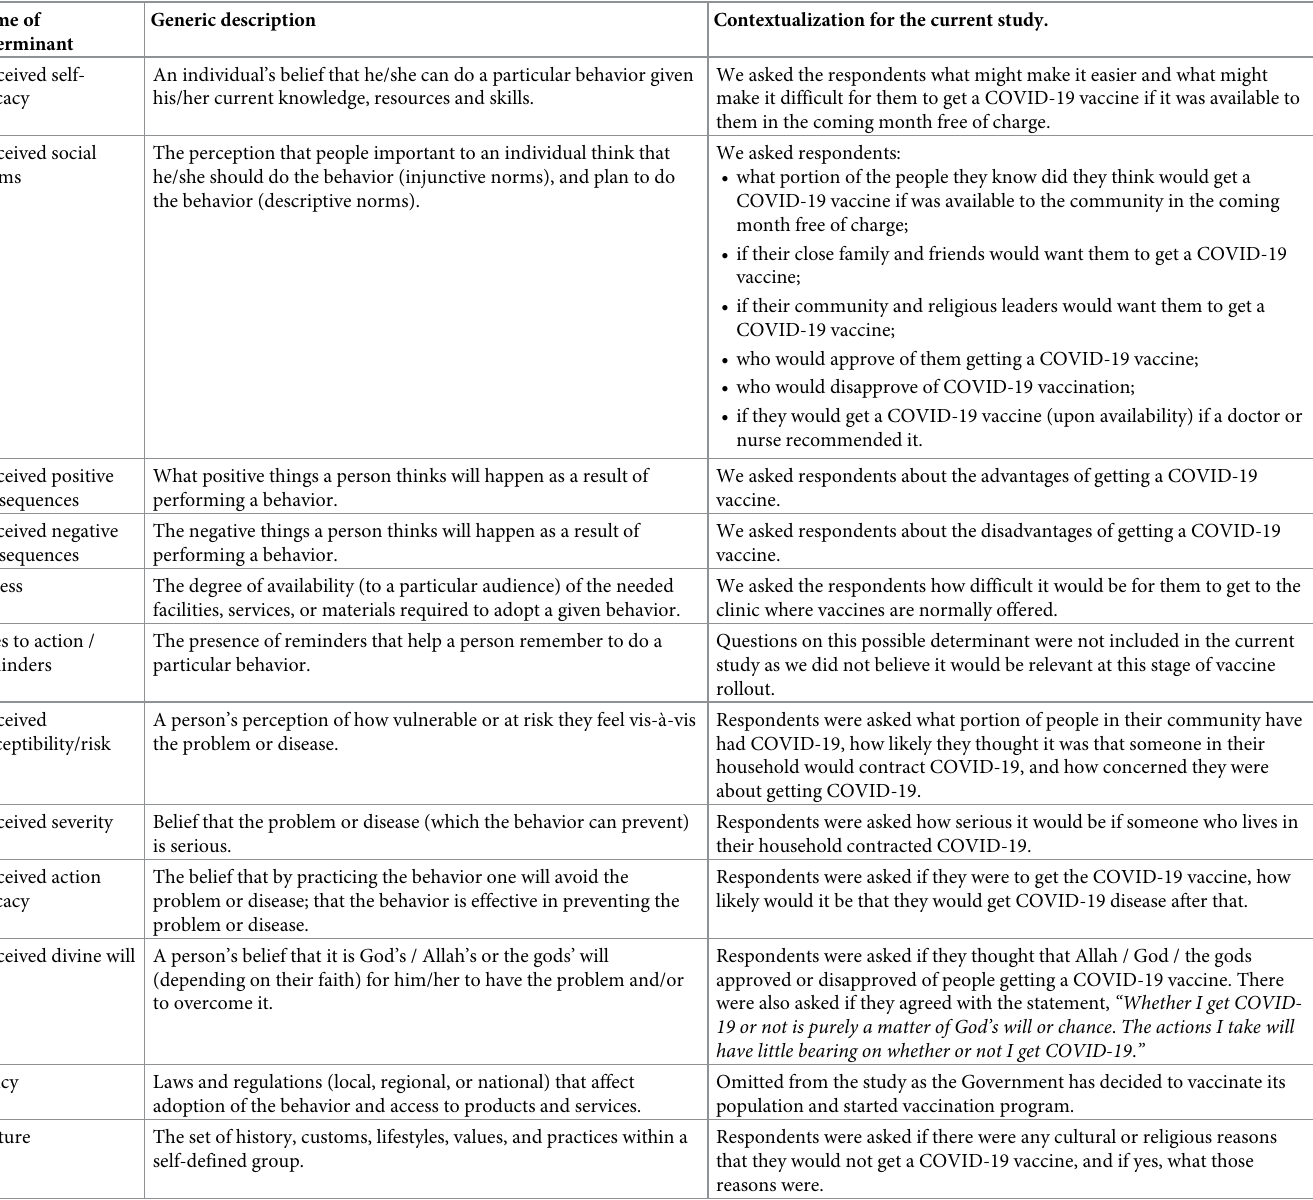
Table 1. The Generic description of the determinants [40] and contextualization for the current study. Name of Generic description Contextualization for the current study. determinant Perceived self-